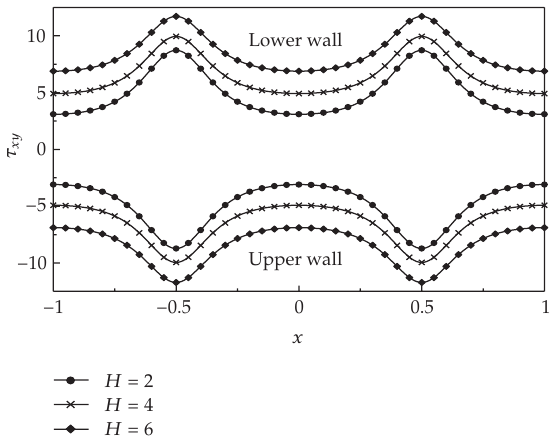
Figure 4: The shear stresses τ xy for α (cid:8) 0 . 5 , θ (cid:8) 1 . 2 , m (cid:8) 3 , N (cid:8) 0 . 6, and di ff erent values of H